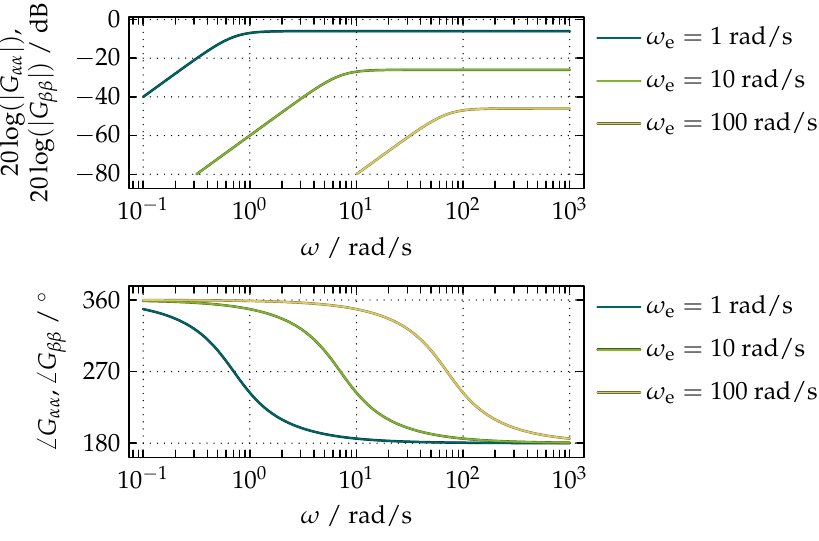
Figure 5. Bode plots common to both G αα and G ββ showing the dependence of the frequency response of the proposed compensation on ω e .